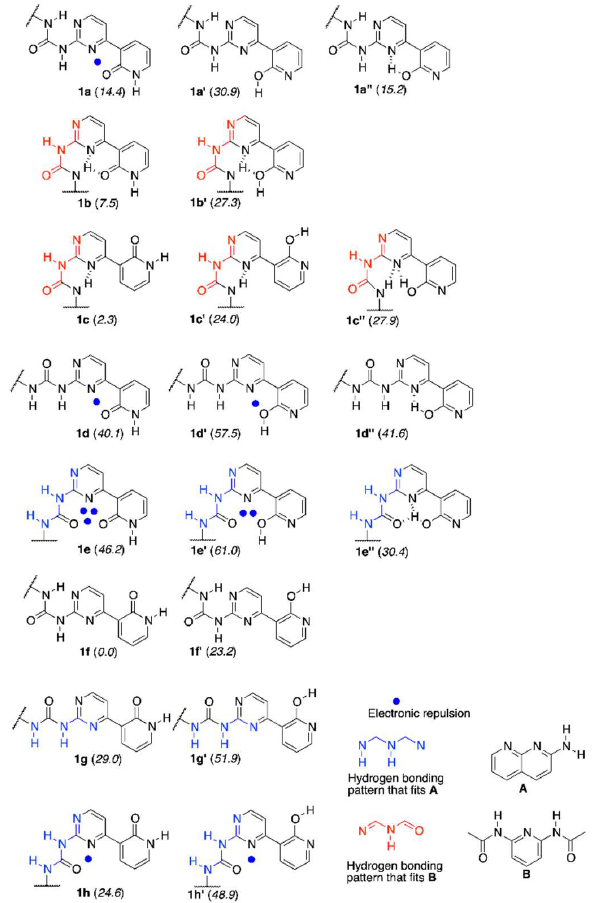
Figure 2. The tautomeric forms of the rotamers of 1 , their DFT-based relative energies (kJ/mol) and structures of guest molecules A and B .